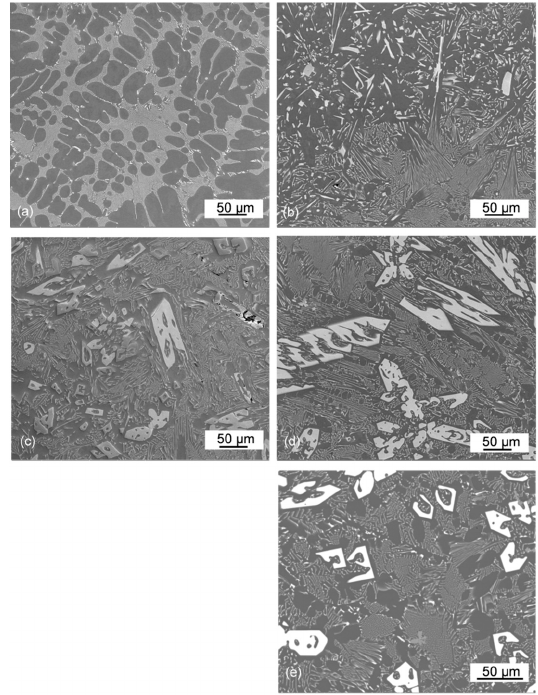
Figure 7. SEM images of the microstructural components in Al–Ce alloys: ( a ) Al–5Ce; ( b ) Al–10Ce; ( c ) Al–15Ce; and ( d , e ) Al–20Ce. The white contrast phase represents the eutectic and proeutectic Al 11 Ce 3 .